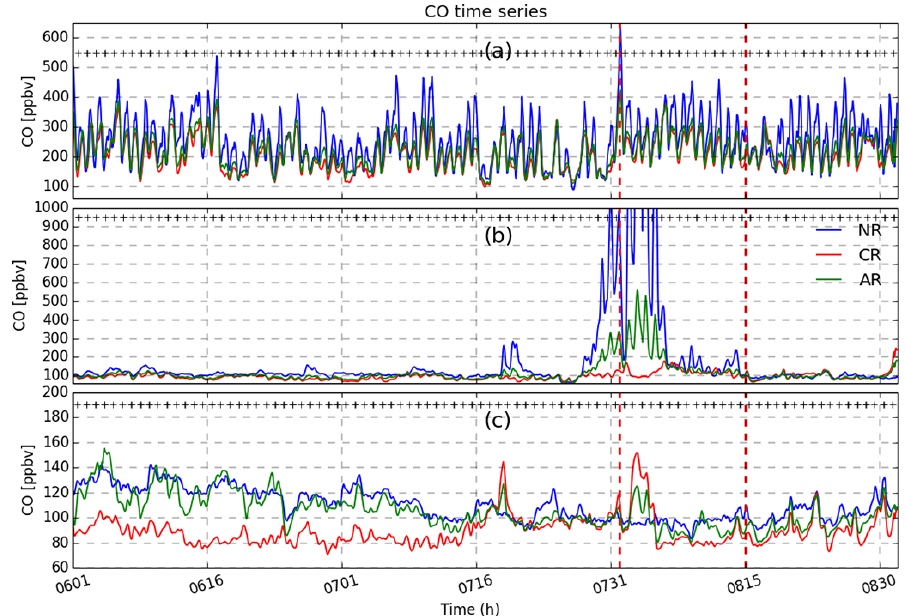
Figure 13. Time series for CO surface concentrations (1 June–31 August) from NR (blue color), CR (red color), and AR (green color) over three different locations represented by squares in Figs. 10 and 11. Top panel: area near Paris; middle panel: area over Portugal, where forest fires occurred; bottom panel: eastern part of the study domain. The labels in the three panels are time in format MMDD ( x axis) and CO concentration in ppbv ( y axis). The plus symbols at the top of each panel indicate availability of observations from the S-5P